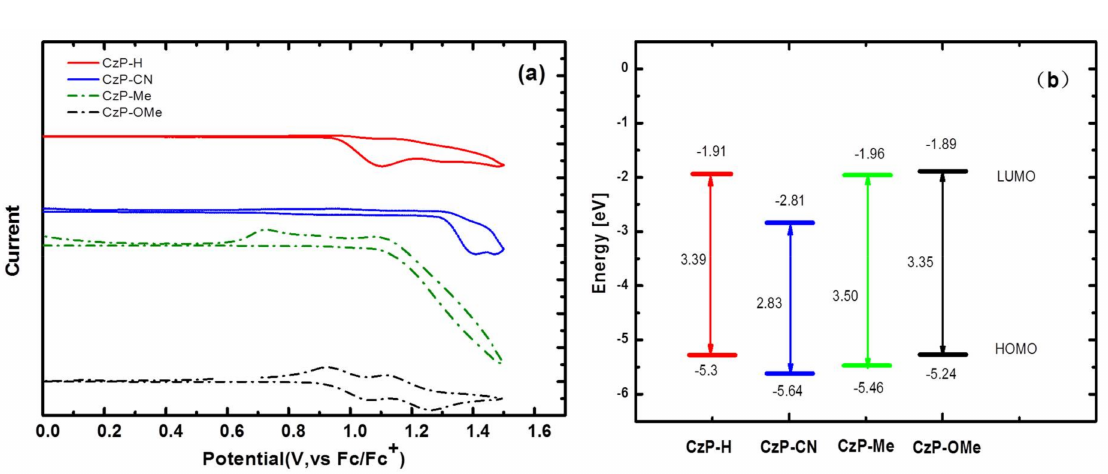
Figure 4. ( a ) Cyclic voltammogram curves of CzP-H, CzP-CN, CzP-Me, and CzP-OMe in solutions and ( b ) an energy-level diagram for CzP-H, CzP-CN, CzP-Me, and CzP-OMe. Table 3. Electrochemical properties of the compounds.